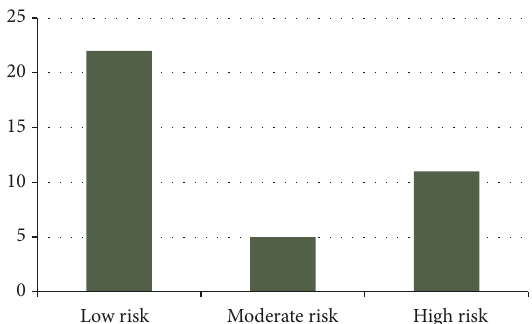
Figure 1: Global cardiovascular risk classification in 10 years of rural workers in the extreme south of